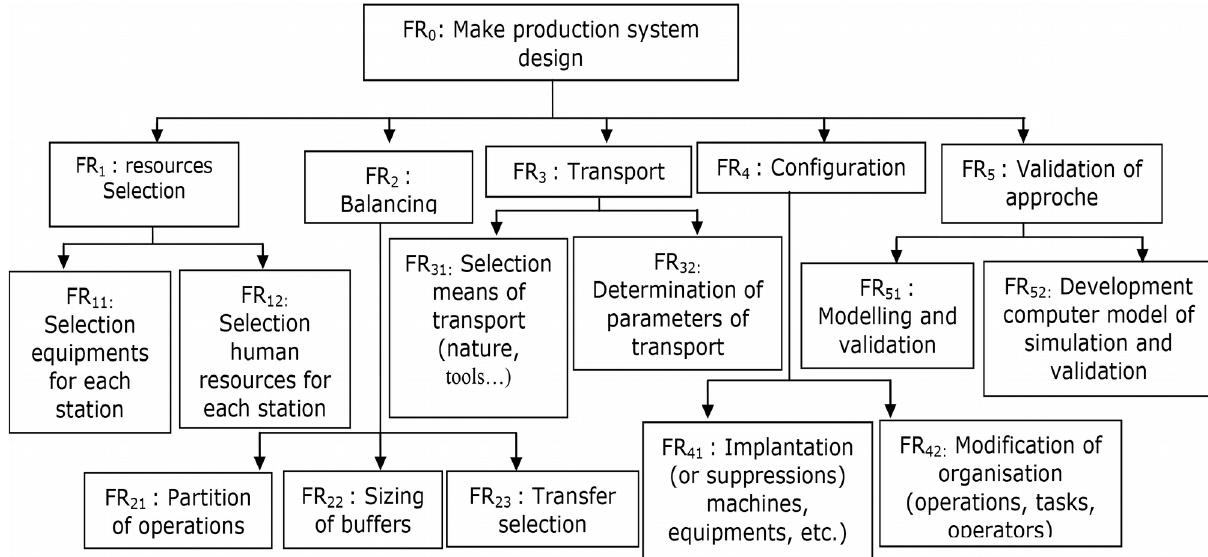
Figure 11. The hierarchical decomposition of FRs